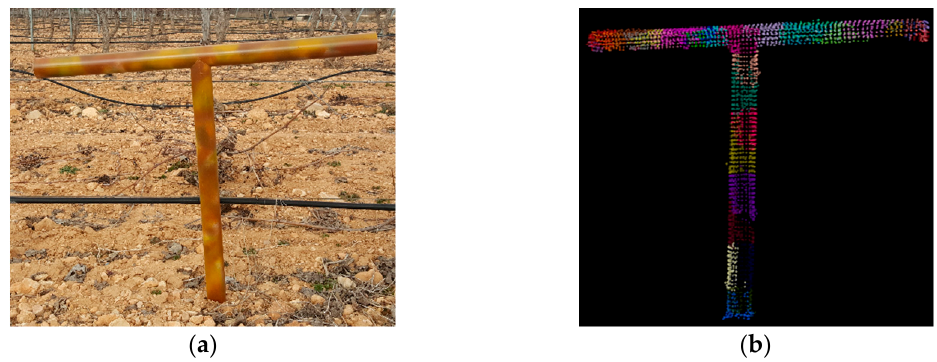
Figure 9. ( a ) VSAO; ( b ) example of a clustering TLS point cloud with the convex hull cluster algorithm.